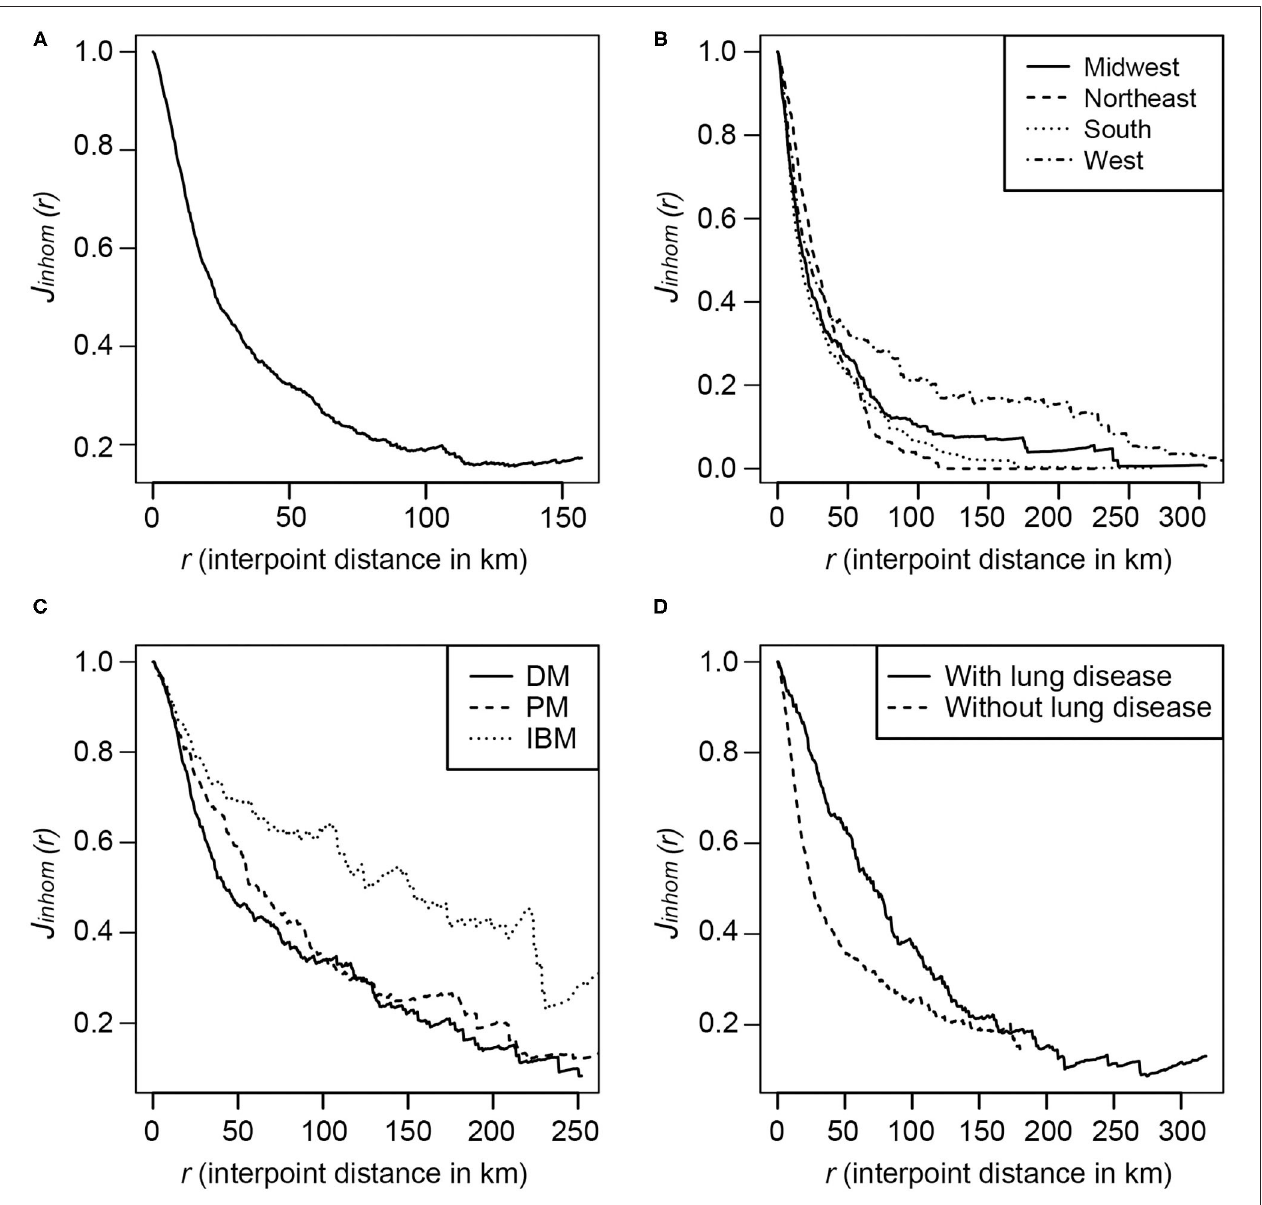
FIGURE 3 | The inhomogeneous J-function estimates for the incidence of myositis in the U.S.in the MYOVISION National Myositis Patient Registry. (A) All IIM cases; (B) By region for 48 contiguous U.S. states: Midwest, Northeast, South and West, according to the definition from U.S. Census Bureau; (C) By IIM subgroups: Dermatomyositis, Polymyositis, and Inclusion body myositis; (D) IIM cases with and without lung